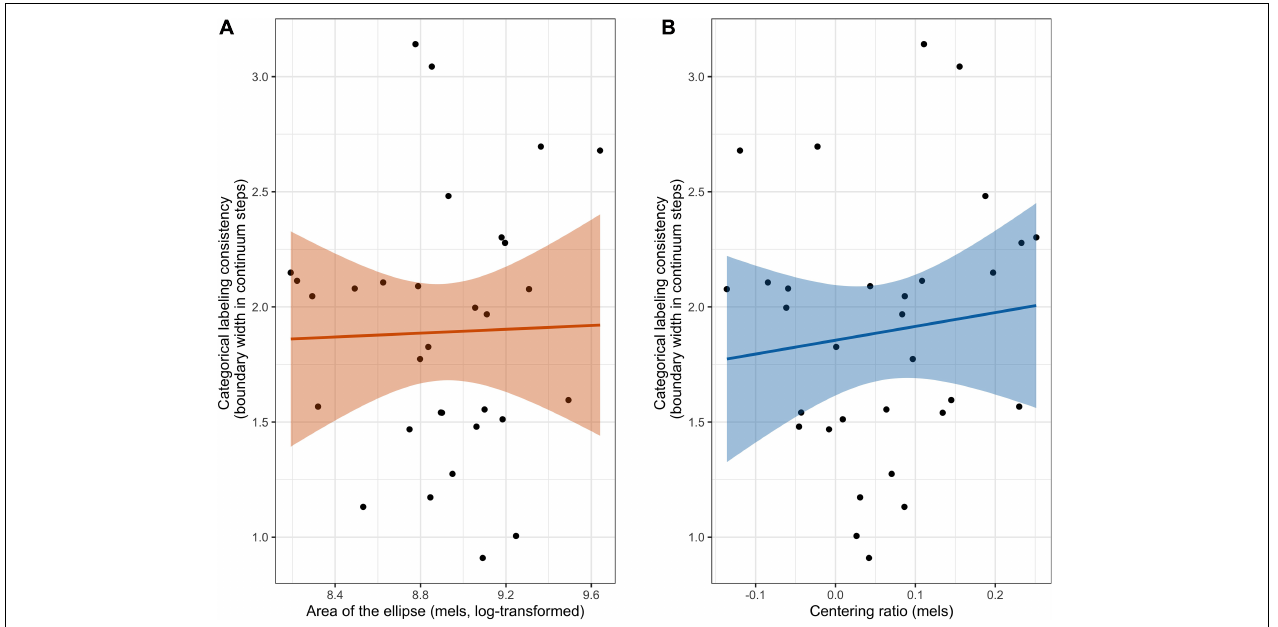
FIGURE 5 | The correlation between categorical labeling consistency and both measures of production variability. The left figure (A) shows the correlation between categorical labeling consistency and area of the ellipse and the right figure (B) shows the correlation between categorical labeling consistency and centering ratio. Shaded band represents a 95% confidence interval around the best-fit